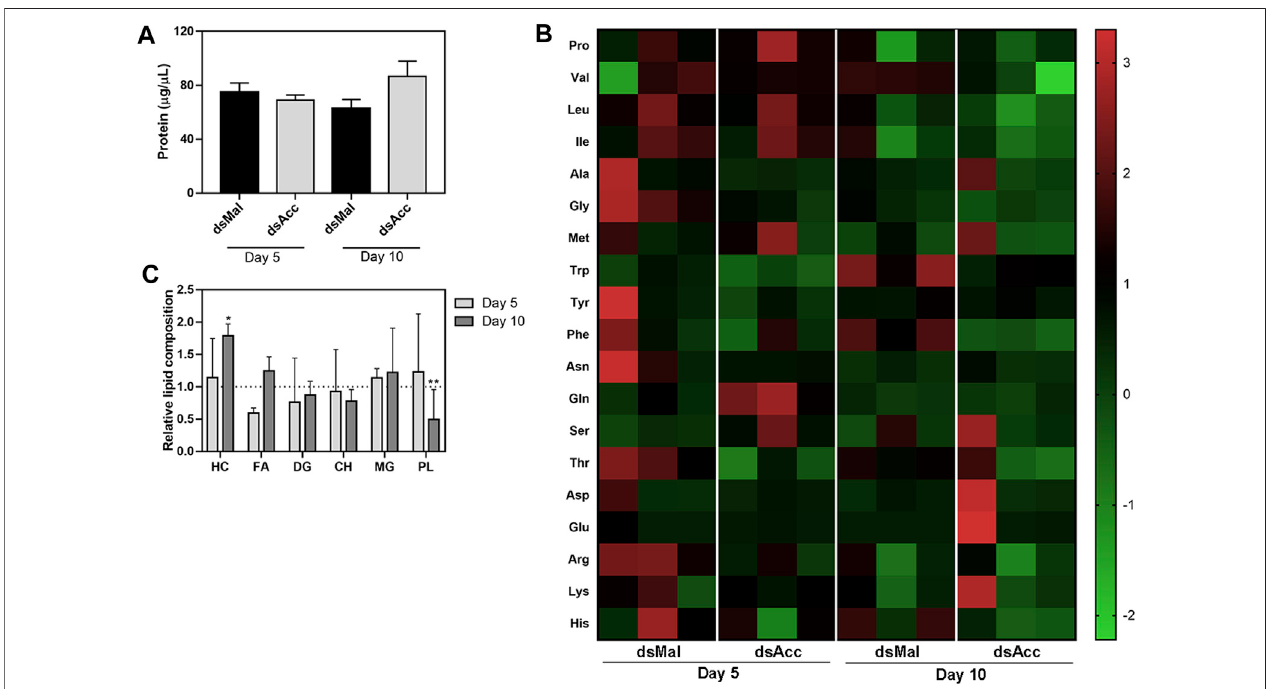
FIGURE 5 | Hemolymph protein, amino acid, and lipid composition after Acc knockdown. Starving adult females were injected with 1 µg of dsRNA for Acc or Mal (control) and were fed 3 days later. At days fi ve and ten after blood meal, hemolymph was collected for the determination of (A) the total protein content (means ± SEM, n=8)and (B) theaminoacidcomposition(datashownforthreeindividualsamplesineach group). (C) Thehemolymphlipidcompositionwasalsoevaluatedatthesame days, and the results are expressed relative to control values for each lipid class (dashed line). Results are means ± SEM for six determinations. (*) and (**): p < 0.05 and 0.01, respectively, by Student ’ s t -test when compared to the corresponding control.